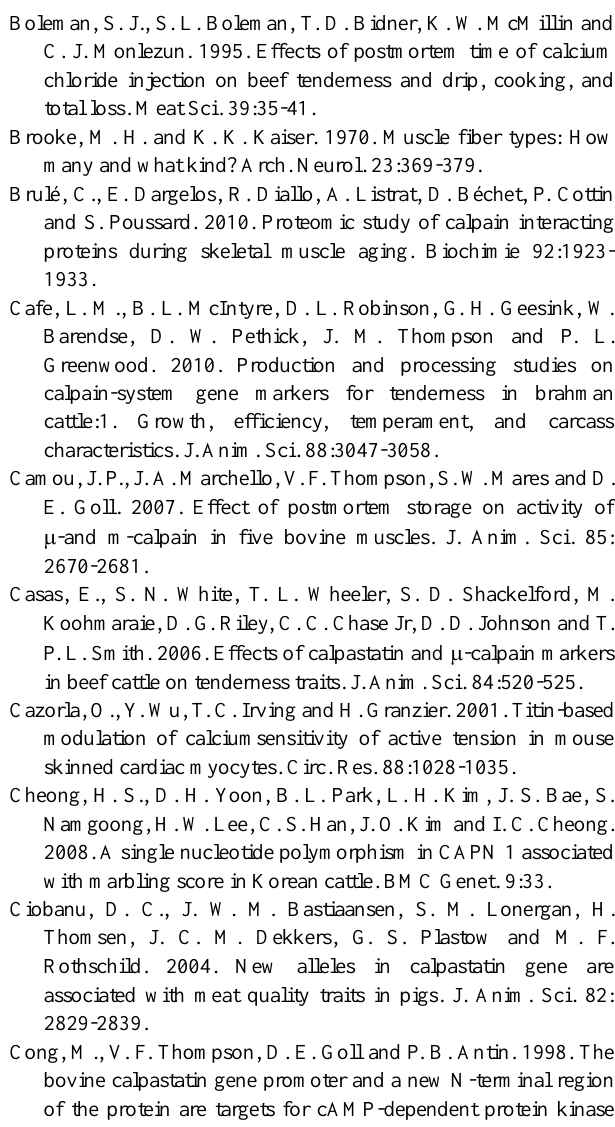
Figure 1. Possible mechanism of CAPN3 in meat